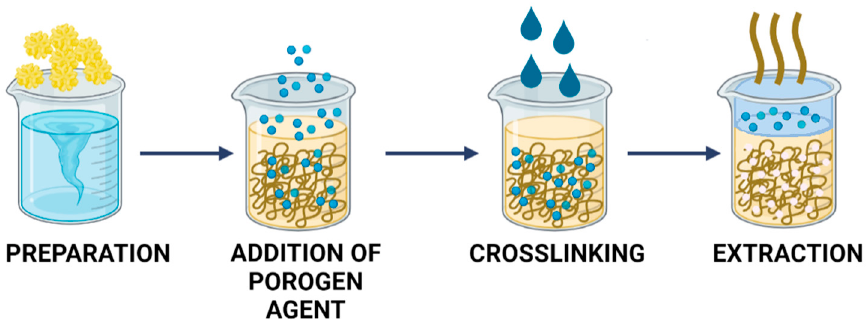
Figure 8. Formation of porous materials by adding a porogen